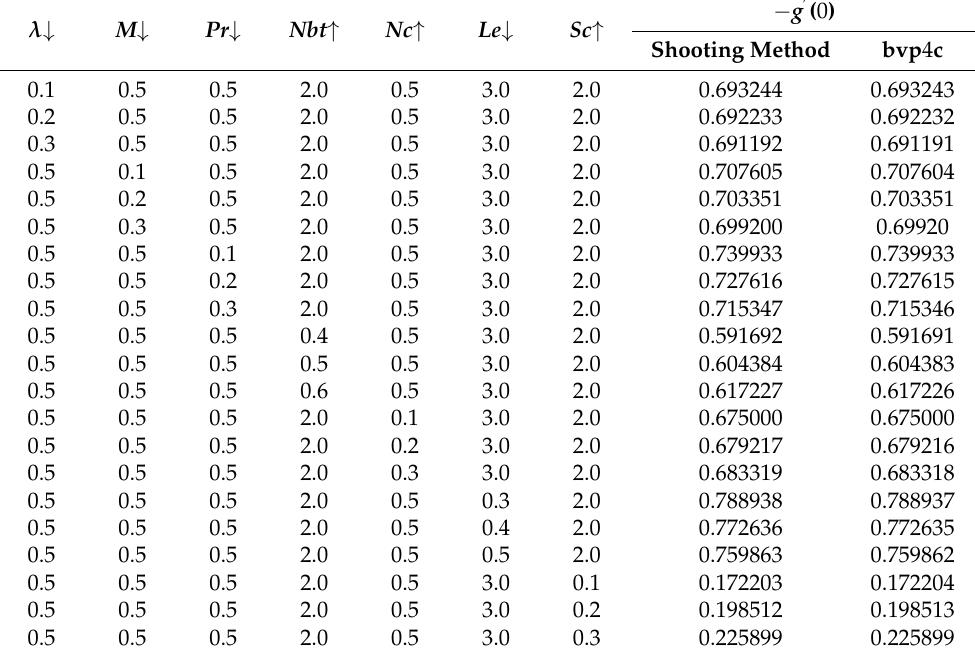
Table 3. Effect of physical parameters on Sherwood number − g (cid:48) ( 0 ) .